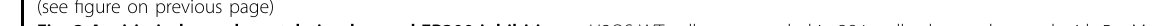
Fig. 3 Aspirin induces deacetylation beyond EP300 inhibition. a U2OS WT cells were seeded in 384-wells plate and treated with 5 mM sodium salicylate (Salic), 100 μ M anacardic acid (AA), 3 μ M C646 or 50 μ M trichostatin A (TSA) for 4 h and then subjected to immuno fl uorescence for the determination of N ε lysine acetylation level (representative image on the left and quanti fi cation on the right). b HCT116 WT and EP300 KO cells were treated with 5 mM Salic for 6 h and N ε lysine acetylation level was determined. c Venn diagram representing acetylated peptide up- or downregulated in HCT116 WT cells treated with salicylate or in HCT116 EP300 KO cells. d U2OS GFP-LC3-expressing cells were transfected with siRNA of the up- or downregulated protein identi fi ed in ( c ), and then treated with 5 mM Salic for 16 h, in the presence of the lysosomal inhibitor ba fi lomycin A1 (100 nM) for the last 2 h of treatment, followed by quantitation of GFP-LC3 dots surface. The results were normalized on the control (Ctrl) unrelated (UNR) siRNA. Effects of siRNA on basal autophagy and effects of Salic-induced autophagy, in each siRNA, are depicted in the table. Results in this fi gure are represented as means ± s.e.m. a , b and as means ± s.e.m. of at least three replicates (with at least 6/8 wells for each conditions) in ( d ). Statistical comparisons were performed as one-way ANOVA compared to Ctrl group (** p < 0.01, *** p < 0.001) ( a ), two-tailed unpaired Student ’ s t test (*** p < 0.001) ( b ), or as p aired Student ’ s t test ( d ), comparing salicylate- t reated to untreated group (*** p < 0.001) and comparing Ctrl UNR DMEM versus Ctrl DMEM of each siRNA ( # p < 0.05) ( p values are listed in Supplementary Table 2). AA anacardic acid, A.U arbitrary unit, Ctrl control, MFI mean fl uorescence intensity, Salic sodium salicylate, TSA trichostatin